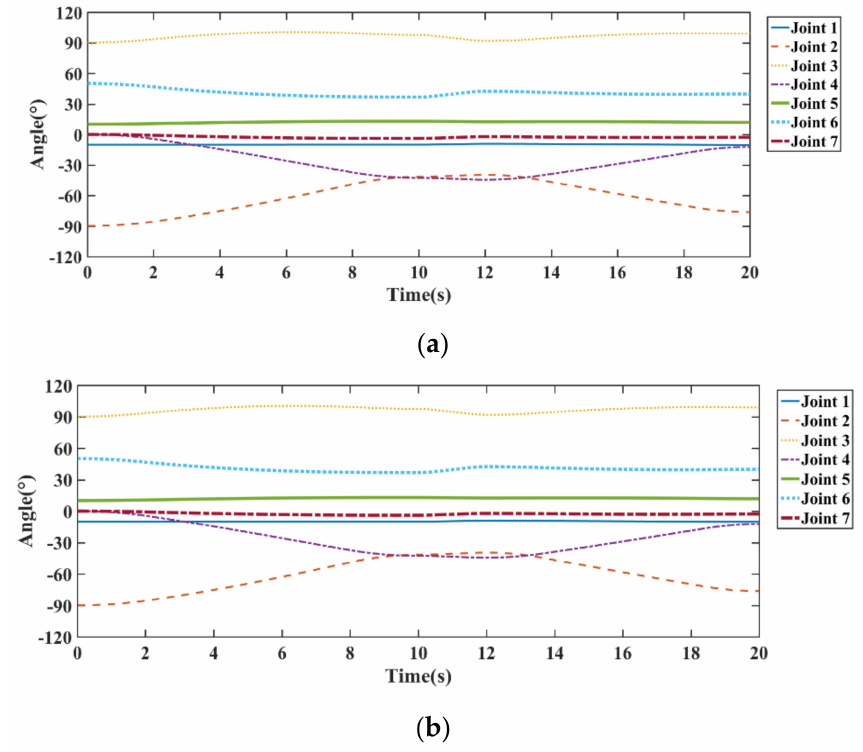
Figure 9. Joint angles of trajectories. ( a ) Without optimization, ( b ) With optimization.